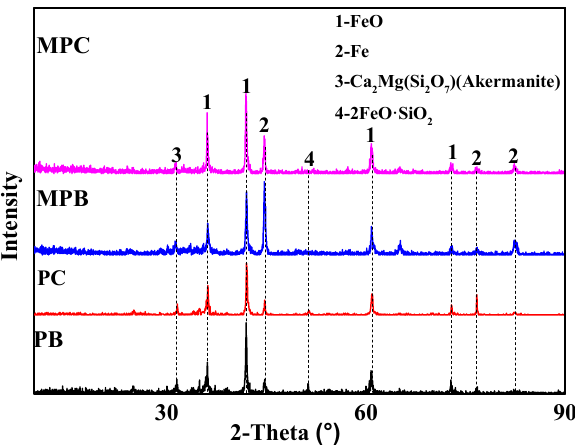
Figure 17. The XRD analysis of different burden composition in the melting temperature.